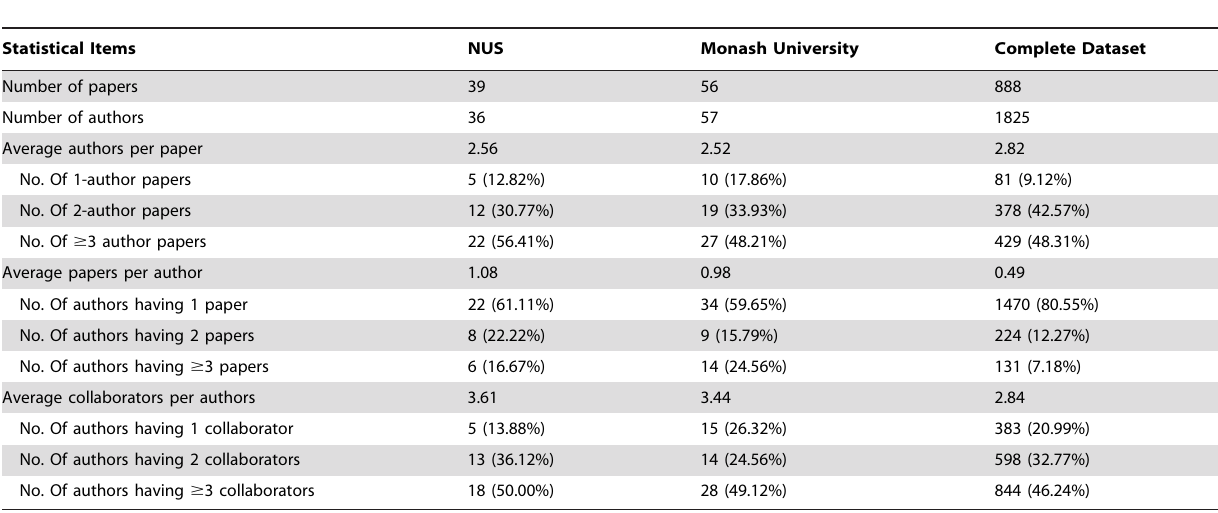
Table 2. Basic statistics of the co-authorship data used in this